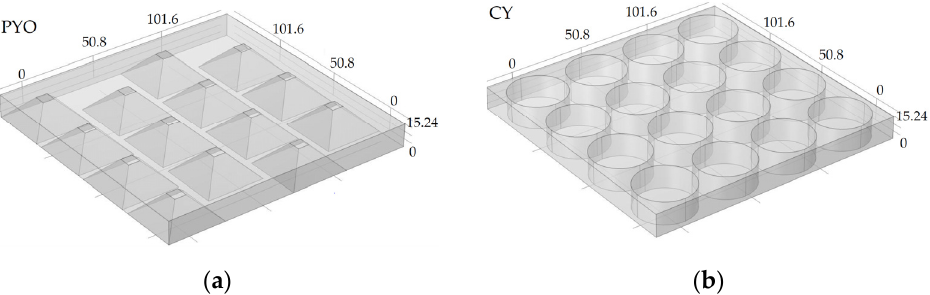
Figure 11. PCM panel designs: PYO—pyramids with offset, CY—cylinders (adapted, copyright 2022 Kamidollayev et al. (http://creativecommons.org/licenses/by/4.0/), accessed on 26 September 2022) [35].